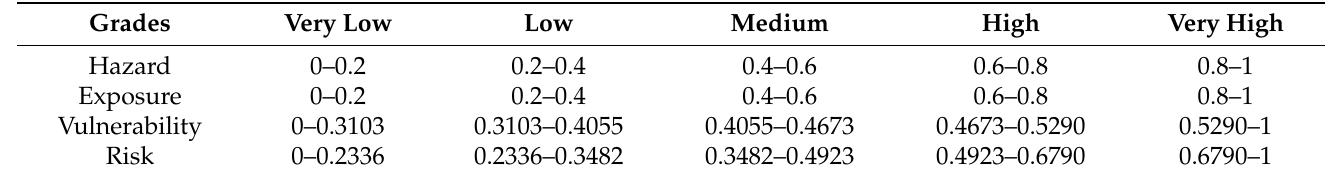
Table A3. Grading thresholds for each factor in 2005.